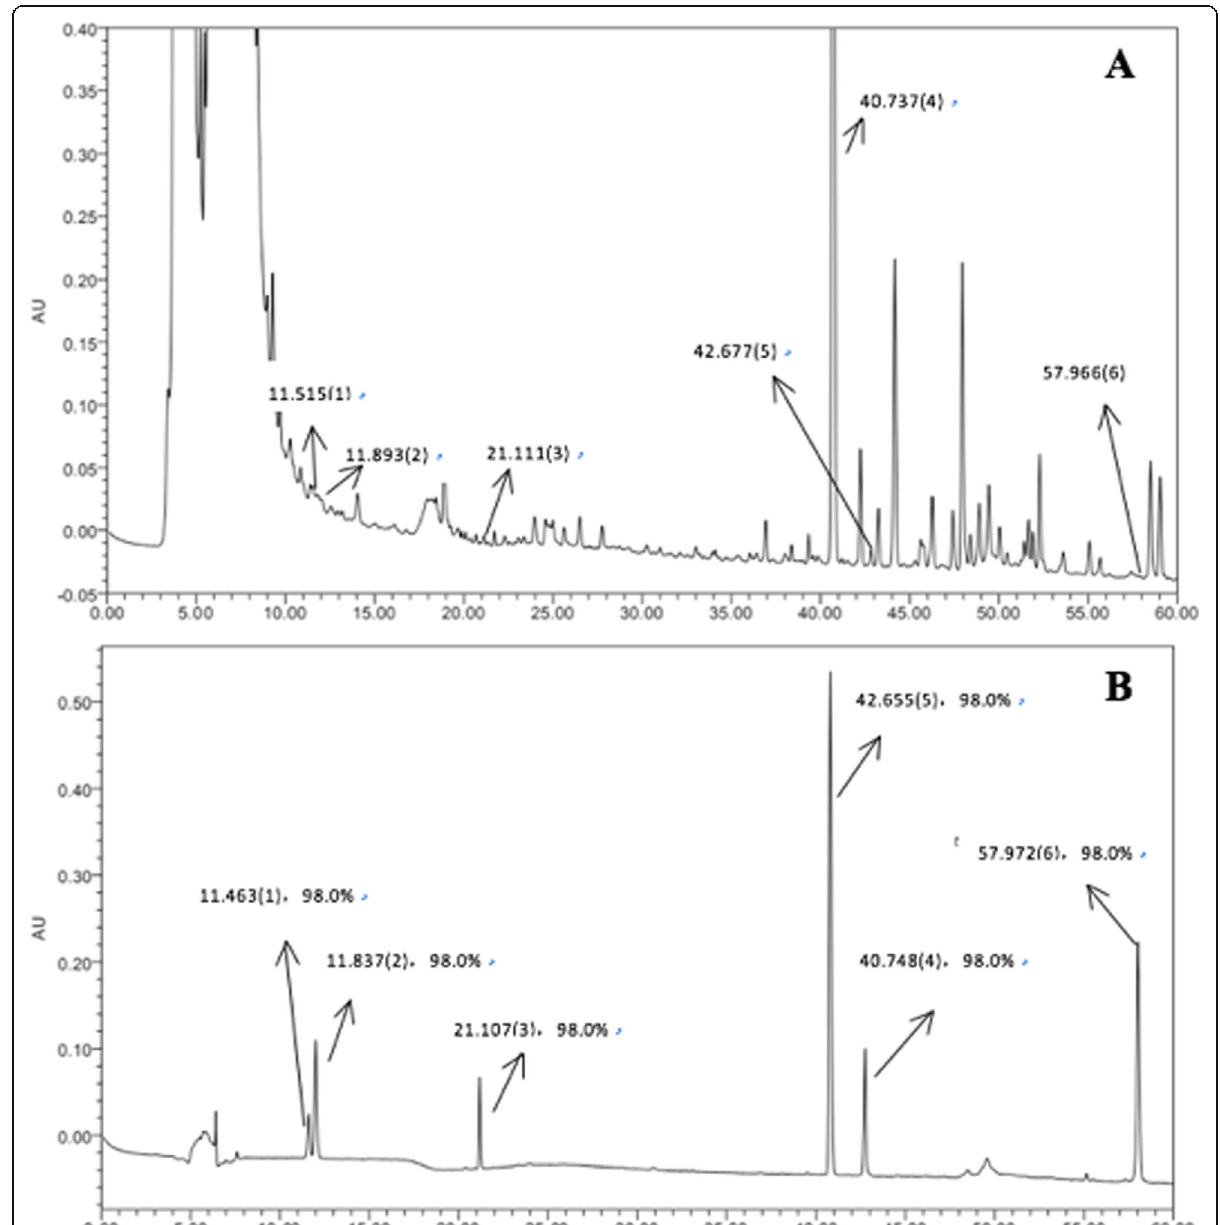
Fig. 1 Chemical standardization of SMS ( a ) and its standard compounds ( b ) by high performance liquid chromatography (HPLC) fingerprint analysis (203 nm). In the HPLC fingerprint at an absorbance of 203 nm, the peaks corresponding to ginsenoside Re (1); ginsenoside Rg1 (2); ginsenoside Rb1 (3); schisandrin (4); ophiopogonin D (5); ruscogenin